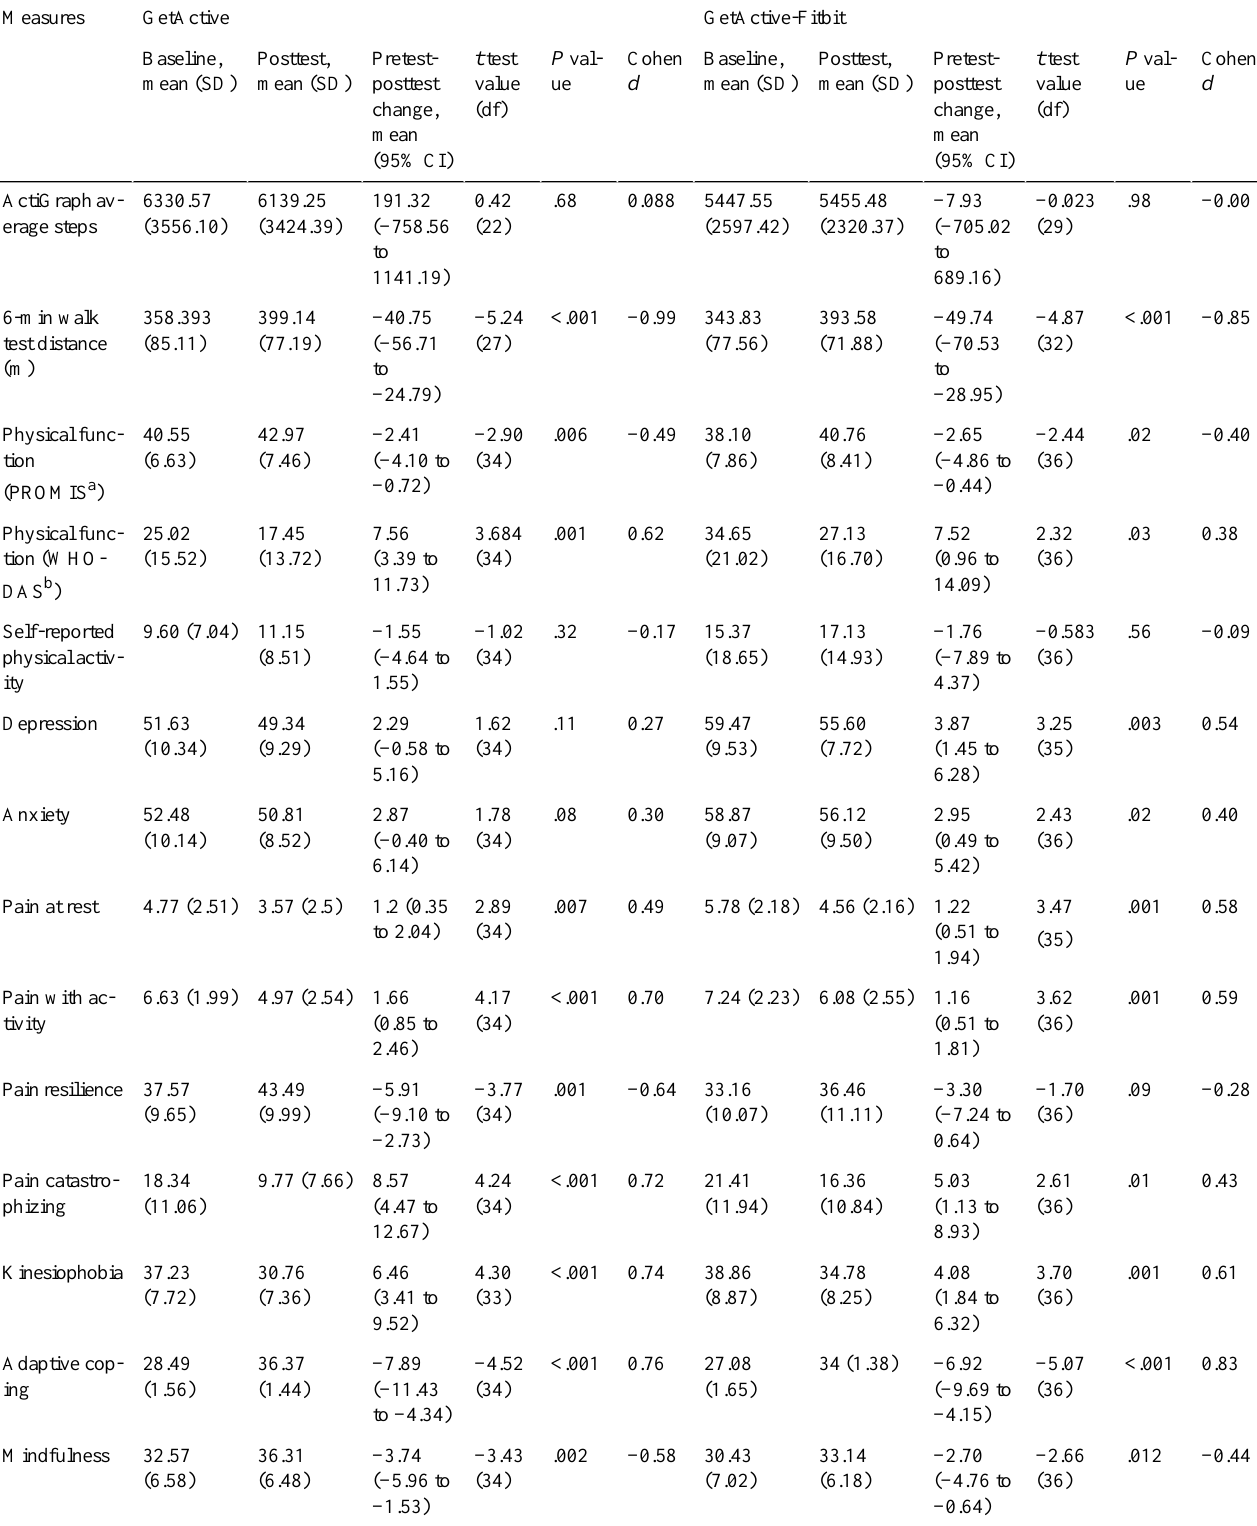
Table 3. Outcome measures.